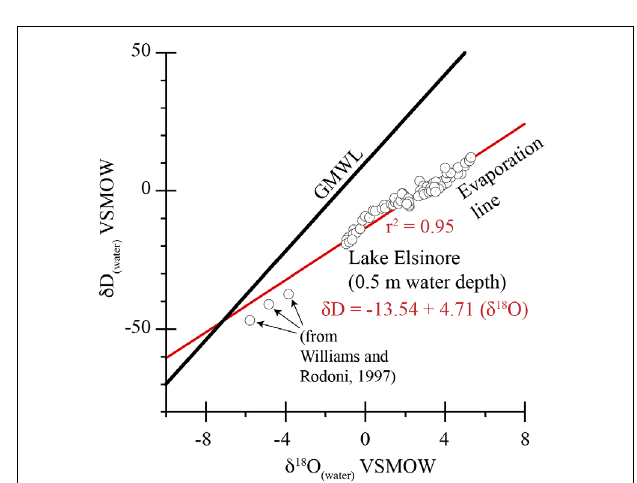
FIGURE 5 | 20 th century 10-year binned δ 18 O ( calcite ) values and lake level data.